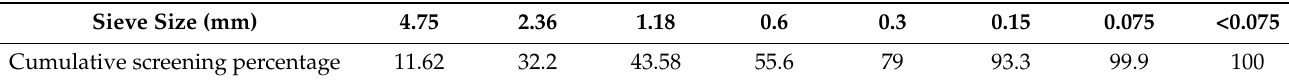
Table 6. The cumulative screening percentage of the natural